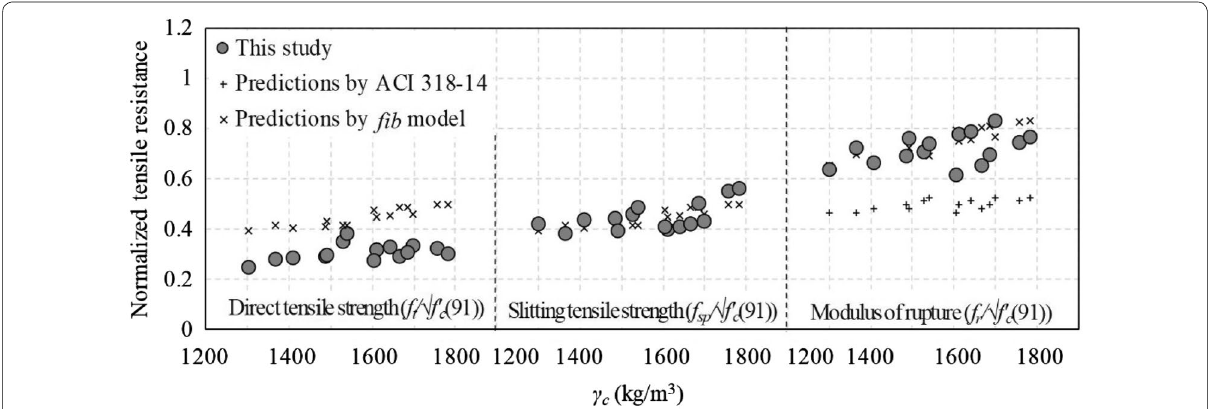
Fig. 10 Effect of γ c on the tensile resistance capacity of the